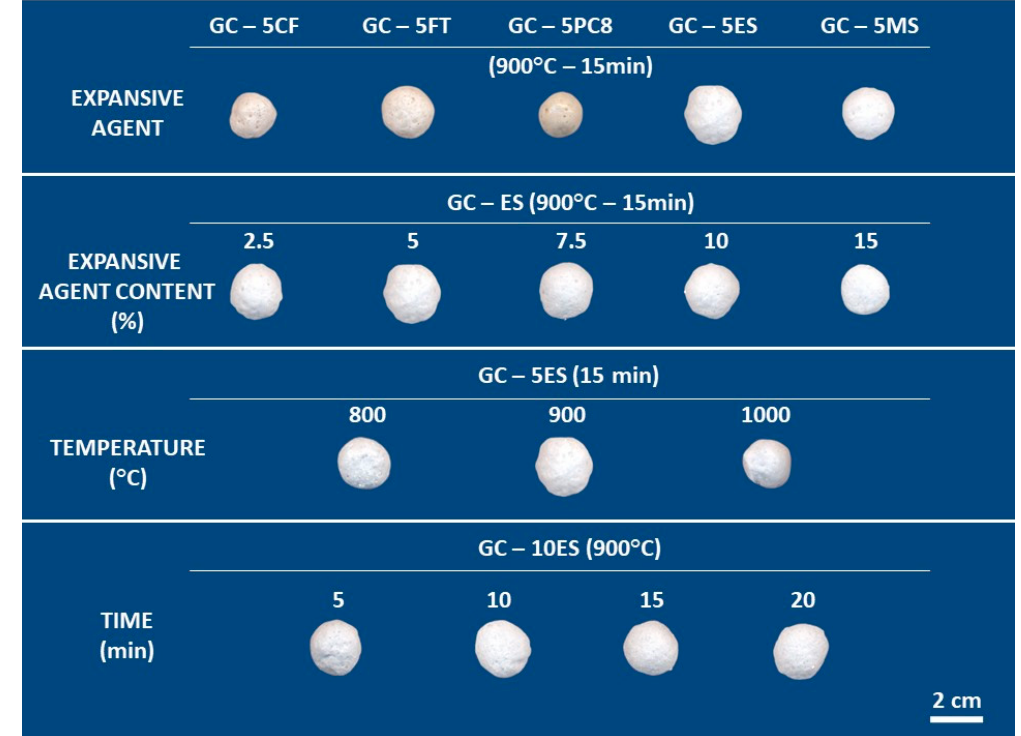
Figure 7. Appearance of the glass lightweight aggregates after the expansion tests performed with different processing parameters on hand–formed pellets.